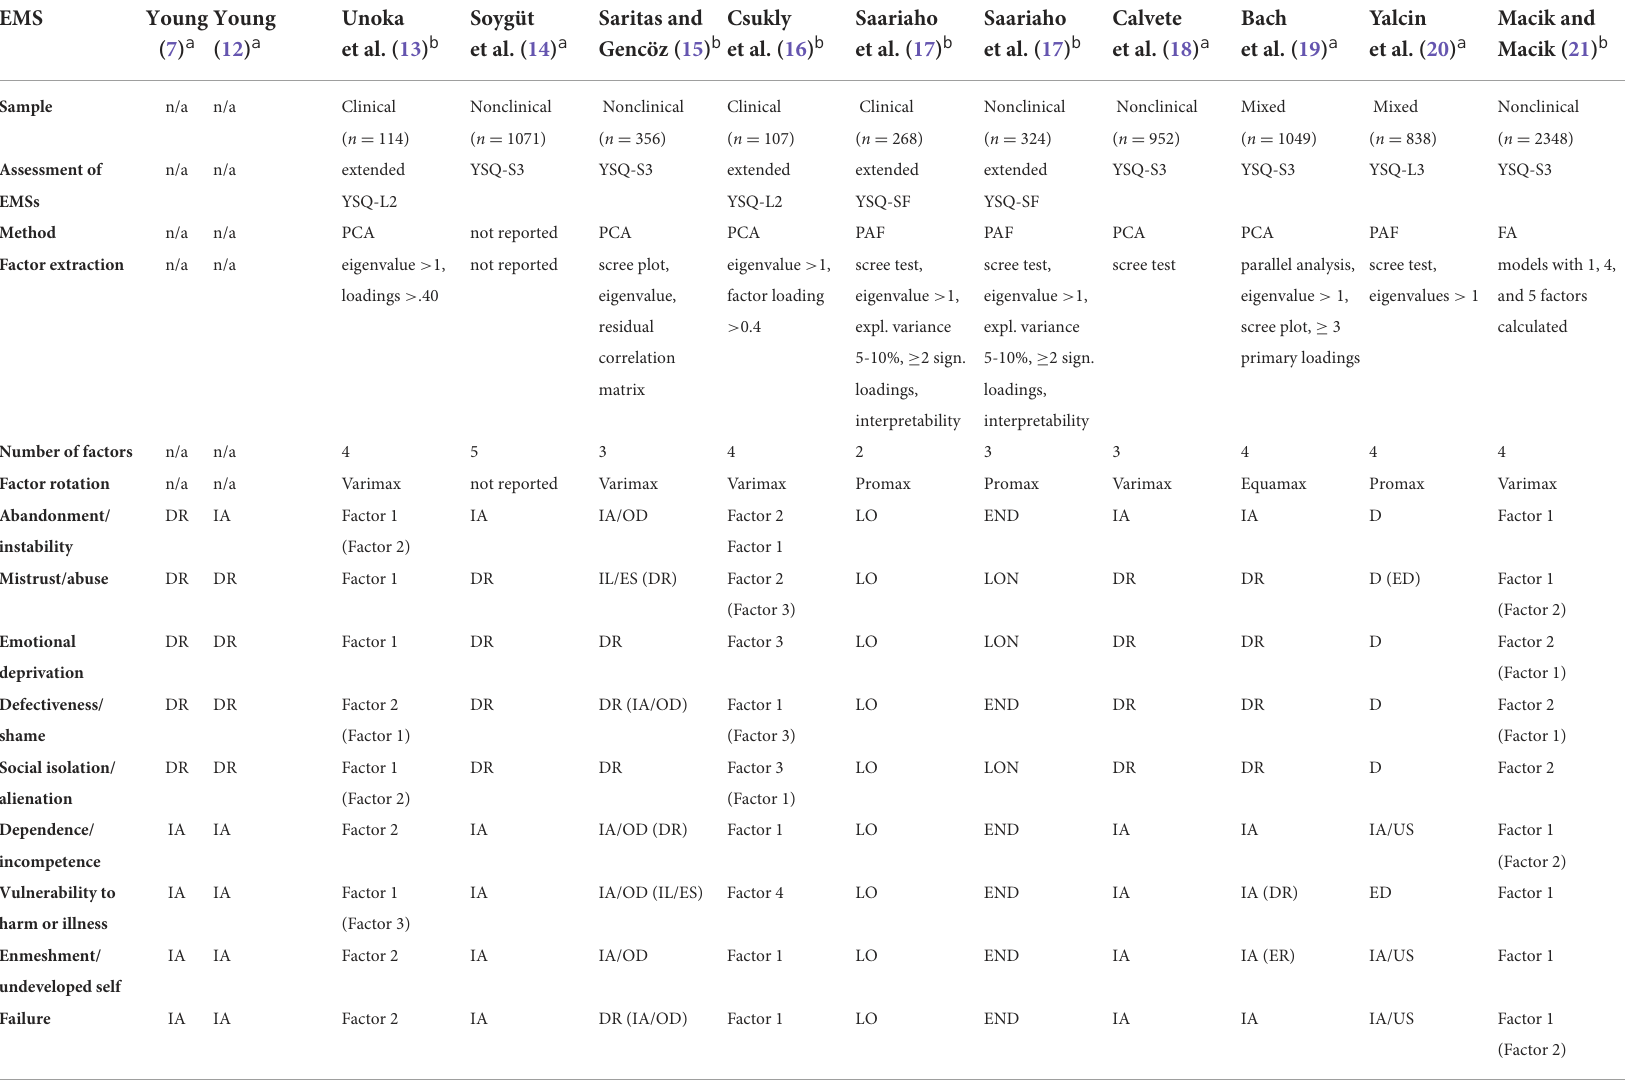
TABLE 1 Proposed EMS